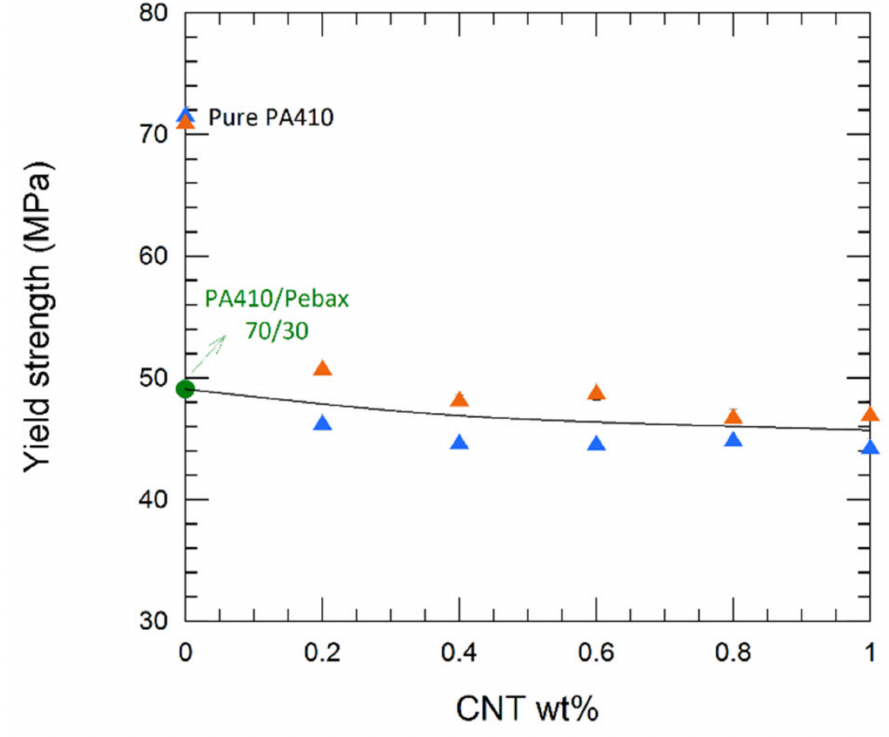
Figure 10. Yield strength of PA410/Pebax/CNT ( (cid:78) ) and PA410/PA6/Pebax/CNT ( (cid:78) ) NCs vs. the CNT content. Pure PA410 and the PA410/Pebax2 70/30 blend have been represented as a